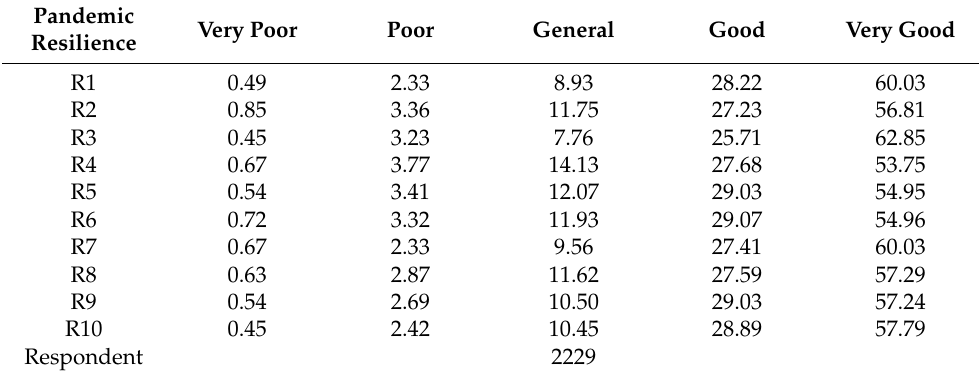
Table 4. Descriptive analysis of pandemic resilience, N